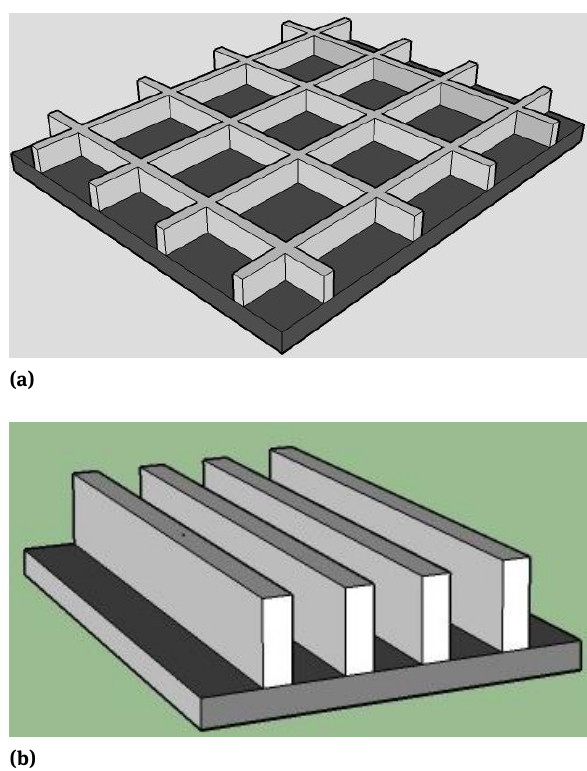
Figure 3: (a) Wafer-reinforced and (b) rib-reinforced magnetoelectric composite